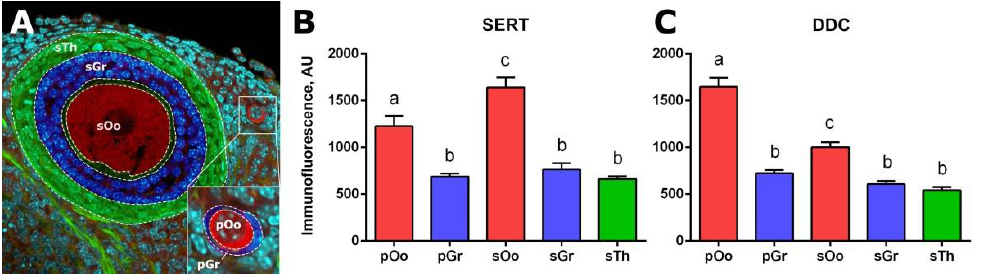
Figure 4. Quantitative analysis of anti-SERT and anti-DDC immunoreactivity in individual cellular compartments of mouse ovaries. ( A ) Cell compartments of the ovary. Dashed lines mark the areas to be analysed: sOo–oocyte, sGr–granulosa cells, sTh–theca cells of the secondary (preantral) follicle; pOo–oocyte, pGr–granulosa cells of the primordial follicle. ( B ) Quantitative analysis of SERT immunoreactivity. ( C ) Quantitative analysis of DDC immunoreactivity. AU–arbitrary units of immunofluorescence. Different letters denote statistical significance between groups at p < 0.05, according to ordinary one-way ANOVA with Holm-Sidak’s multiple comparisons test.